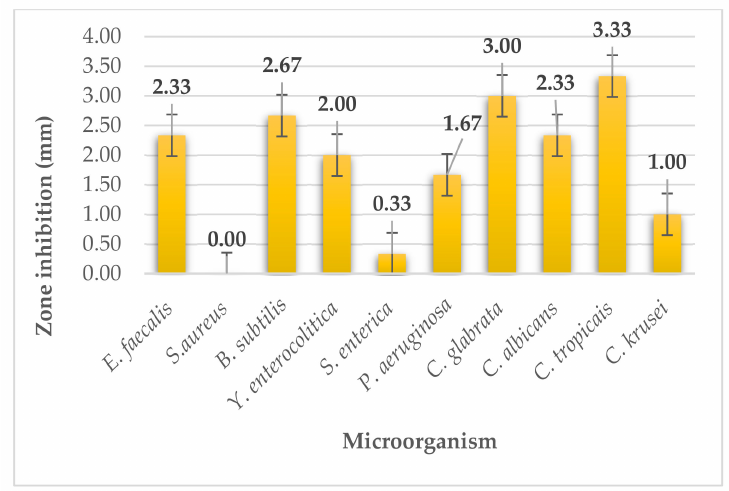
Figure 11. Antimicrobial activity of